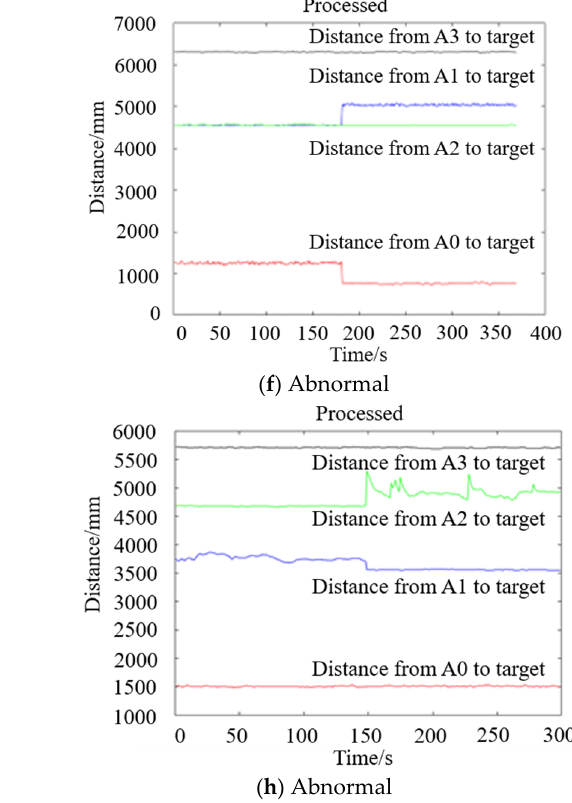
Figure 3. Four sets of data to remove “useless” points.